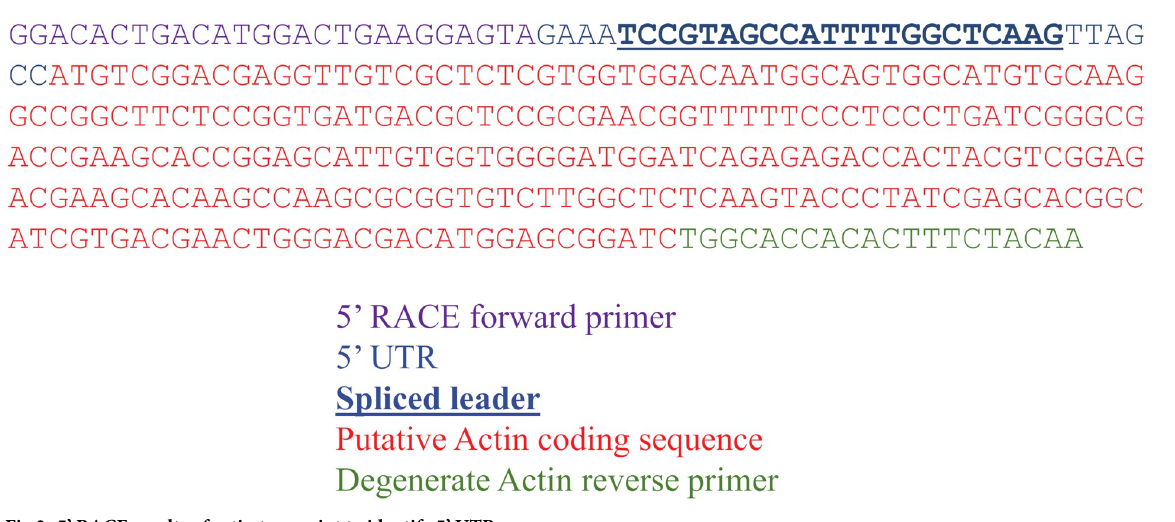
Fig 3. 5’ RACE results of actin transcript to identify 5’ UTR